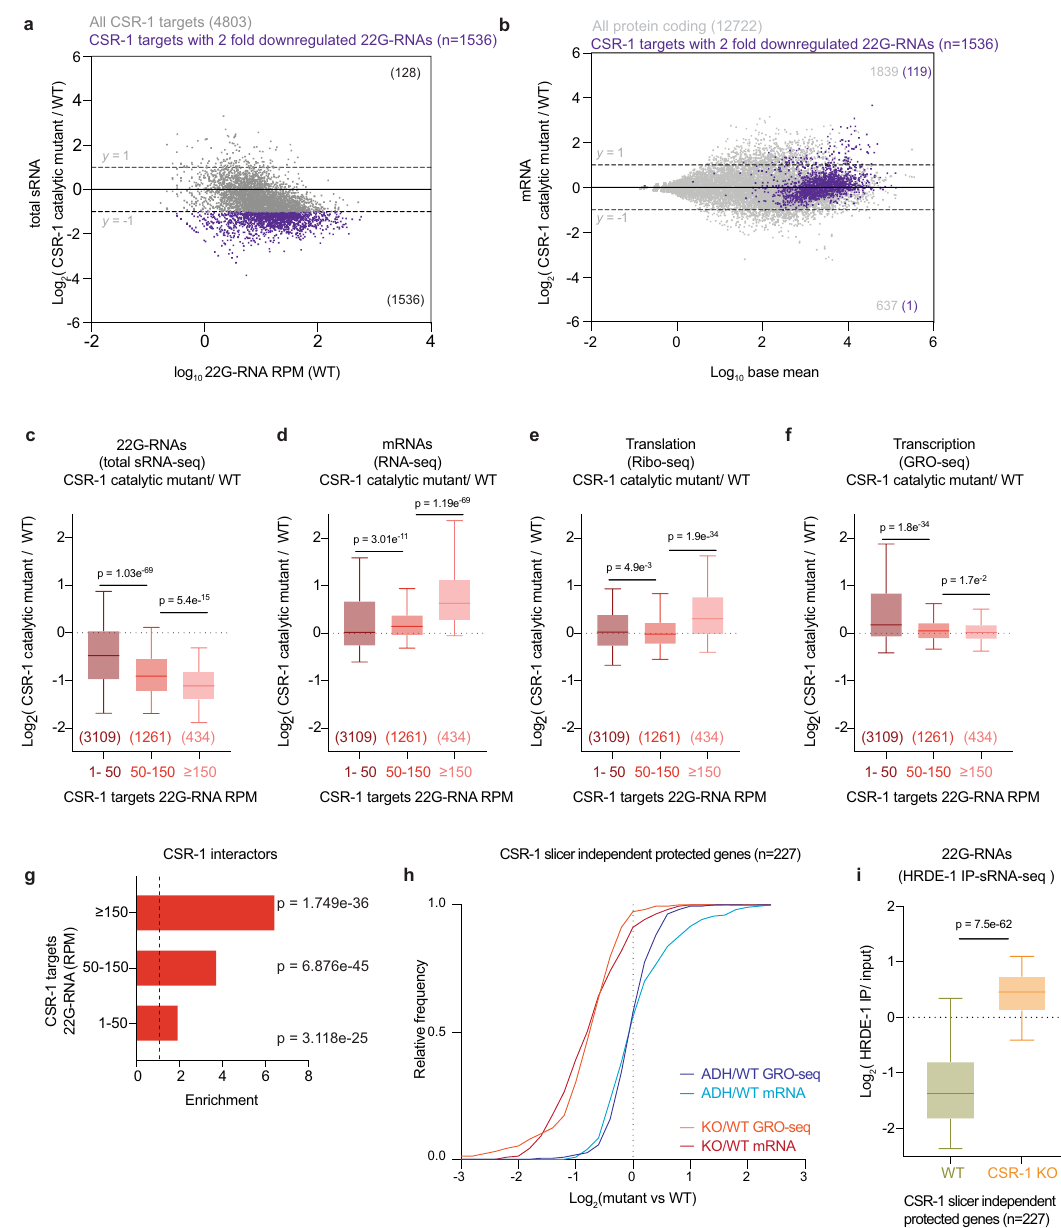
Fig. 1 Defects in CSR-1 catalytic activity mainly impacts 22G-RNA abundance. a MA-plot showing total 22G-RNA log 2 fold-change for CSR-1 ADH (catalytic mutant) compared to WT. The number in parenthesis indicates the number of misregulated genes ≥ 2-fold. The average from two biological replicates is shown. b MA-plot showing mRNA log 2 fold-change for CSR-1 ADH compared to WT. Genes with 22G-RNAs with twofold downregulation in CSR-1 ADH compared to WT are highlighted in purple. The average from two biological replicates is shown, with “ base mean ” computed using DESeq2 89 . The number in parenthesis indicates the number of misregulated genes ≥ 2-fold (gray dots — all protein-coding genes, purple- CSR-1 targets with twofold downregulated 22G-RNAs). c – f Box plots showing the log 2 fold-change in CSR-1 ADH compared to WT strain for total 22G-RNAs (sRNA-seq) (2 biological replicates) ( c ); or mRNAs (RNA-seq) (2 biologically replicates) ( d ); mRNAs engaged in translation (Ribo-seq) (3 biological replicates) ( e ); and nascent RNAs (GRO-seq) (2 biologically replicates) ( f ), The distribution for the CSR-1 targets with 22G-RNA in CSR-1 IP with 1 – 50 RPM, 50 – 150 RPM, or ≥ 150 RPM is shown (gene list in Supplementary Data 1). g Enrichment of CSR-1 interactors in different CSR-1 targets categories based on 22G-RNA abundance. The dashed line at 1 indicates no enrichment. P -values were calculated by Exact hypergeometric probability using an automated tool available at http:// nemates.org/MA/progs/overlap_stats.html. h Cumulative frequency distribution for CSR-1 slicer-independent protected targets (downregulated in CSR-1 KO compared to the CSR-1 ADH in GRO-seq, gene list in Supplementary Data 1). The comparison shows GRO-seq ( P = 1.6e − 49 ) and RNA-seq ( P = 4.2e − 37 ) for CSR-1 KO or CSR-1 ADH compared to WT. i Box plots showing the log 2 fold-change of 22G-RNAs (sRNA-seq) in HRDE-1 IPs compared to input in WT, CSR-1 KO strains. Data is representative of two biological replicates. For all the box plots, the line indicates the median value, the box indicates the fi rst and third quartiles, and the whiskers indicate the 5th and 95th percentiles, excluding outliers. Two-tailed P -values were calculated using Mann – Whitney – Wilcoxon tests. The sample size n (genes) is indicated in parentheses. Source data are provided as a Source Data fi